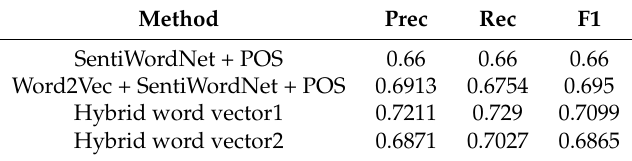
Table 6. Accuracy comparison of Sweeney’s model and sentiment-aware word